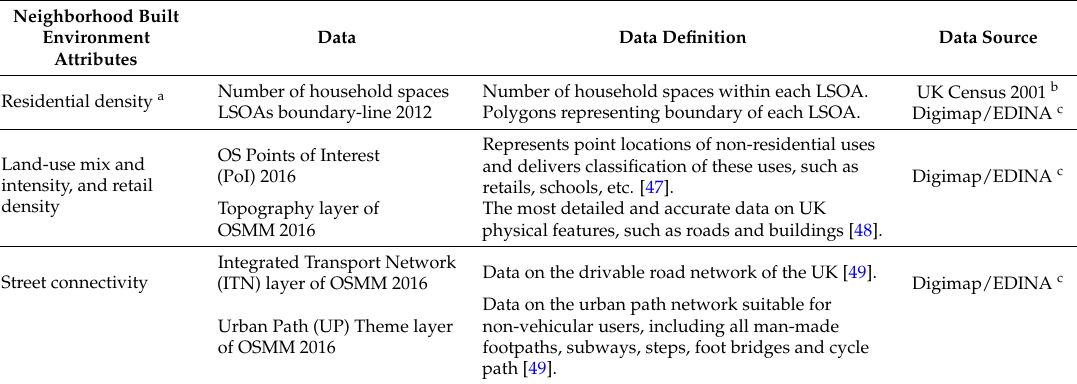
Table 2. Data used for objective measures of neighborhood built environment